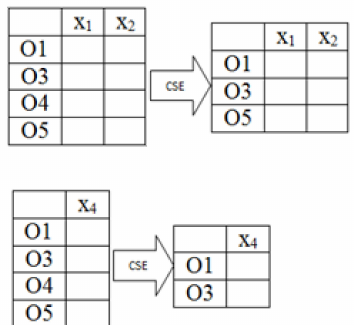
Figure 4. Additional instance selection in the candidate training sets.